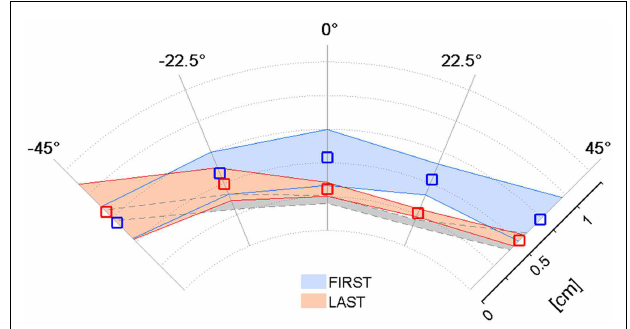
FIGURE 5 | Effect of training on the Shift parameter in theVFF condition . Mean absolute S hift values and corresponding standard deviation over the target set with both visual and force feedback on the first (blue) and last (red) day of the kinesthetic training; the gray shaded area corresponds to the performance of the healthy control